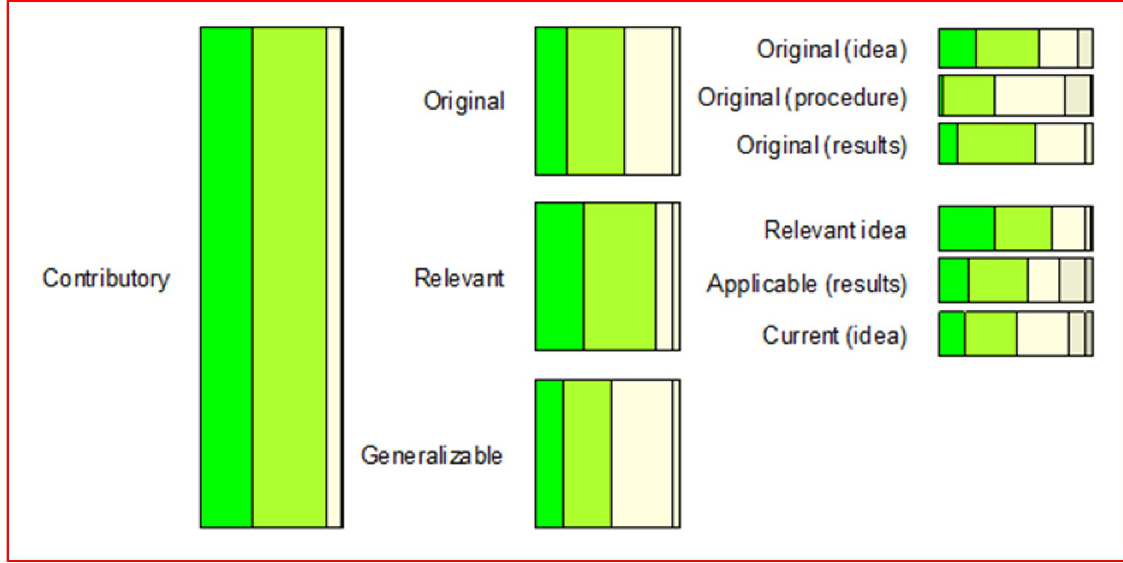
Fig 3. Responses regarding the contributory main concept, ranked from 1–5, where 5 is “of crucial importance”.